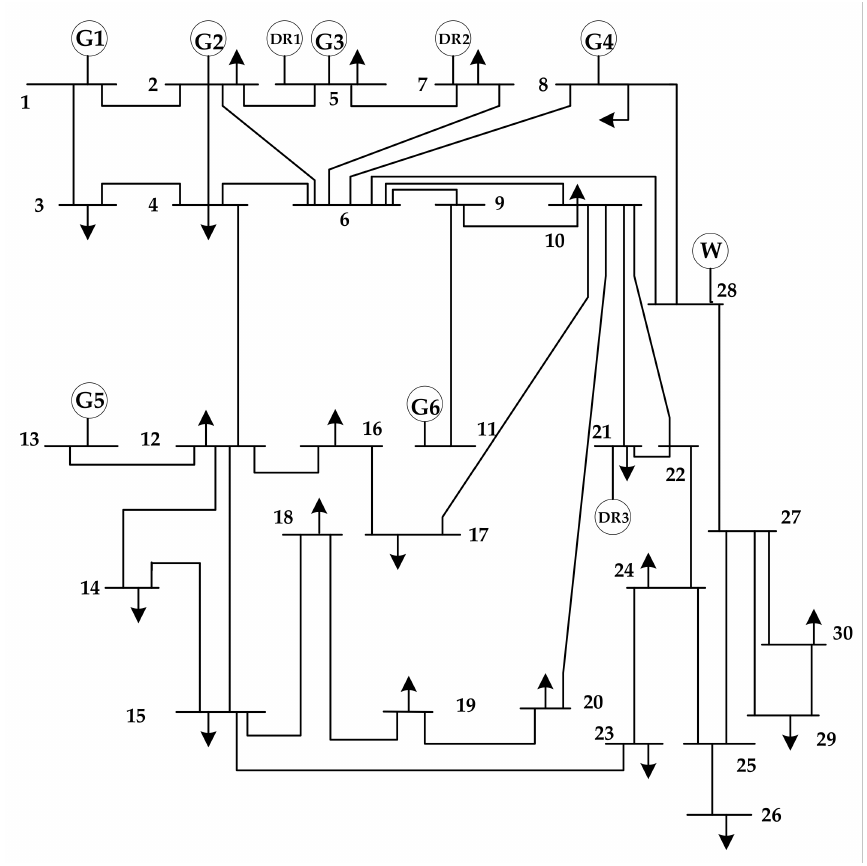
Figure 2. Topology of the modified 30-bus test